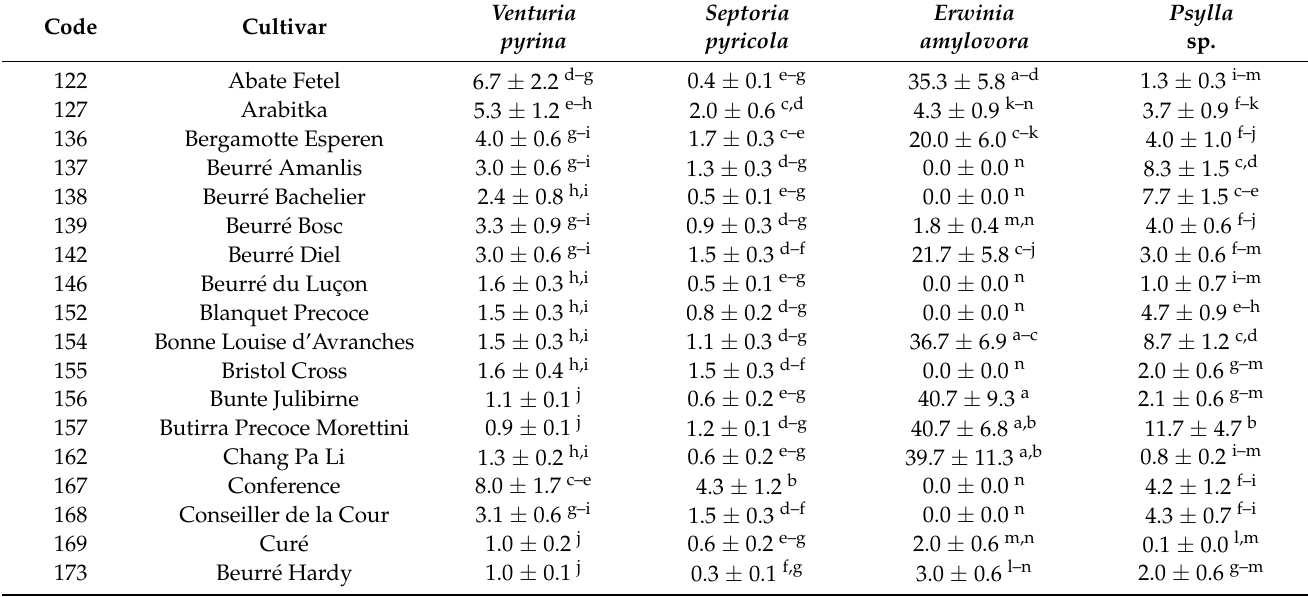
Table 3. Response to the principal diseases and pests of 50 non-Romanian (international) pear cultivars (as degree of attack, DA %) 1